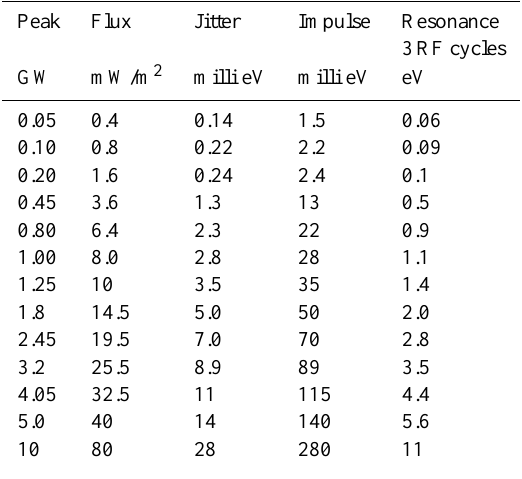
Table 1. Calculated electron energies at 100-km altitude for pulsed Hertz antennas radiating at